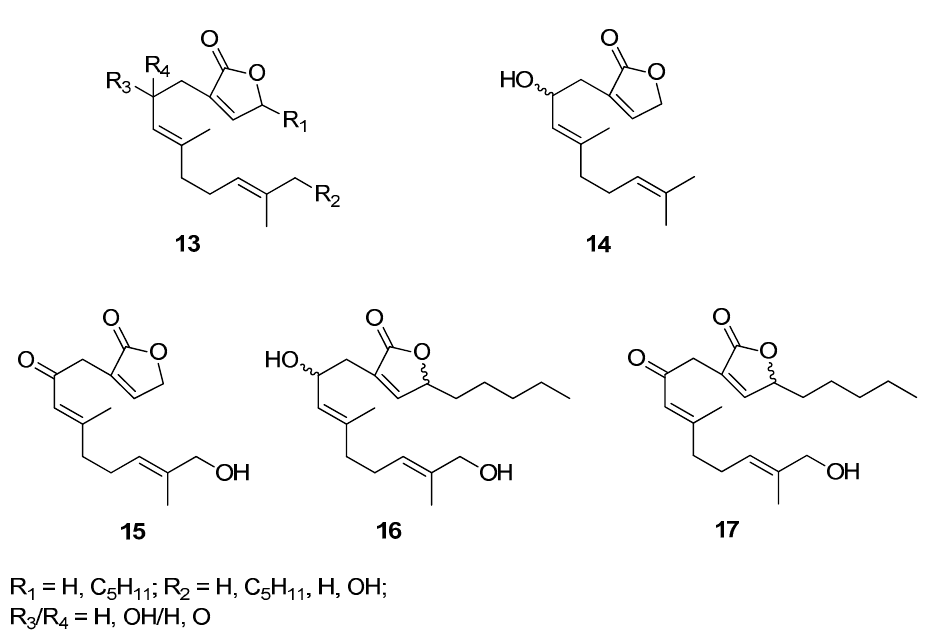
Figure 6. Selected examples of geraniol-butanolide hybrid compounds.